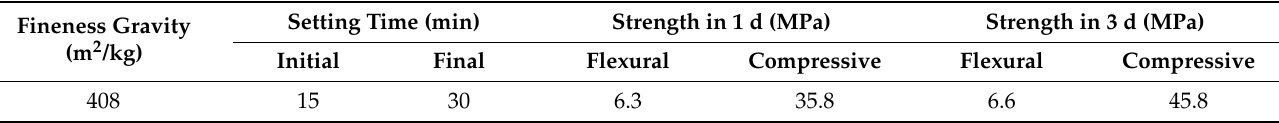
Table 2. Properties of the CSA